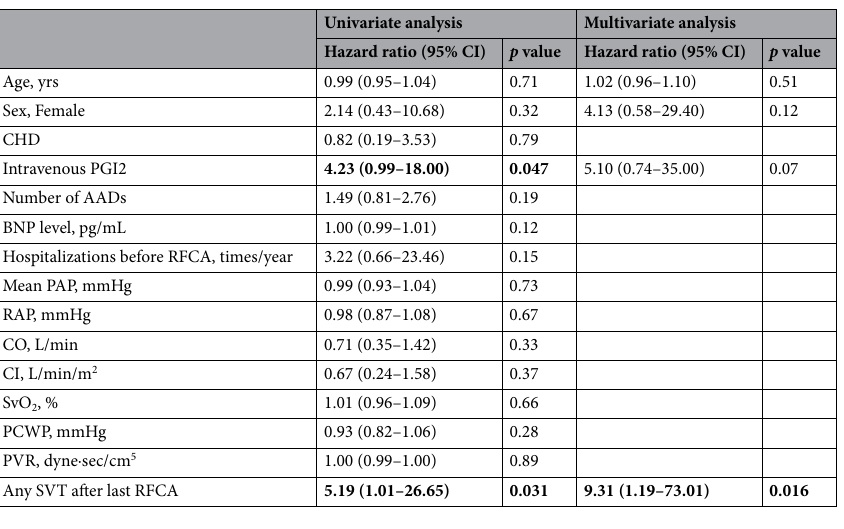
Table 2. Cox regression analysis of risk factors for mortality. AAD antiarrhythmic drug, BNP: brain natriuretic peptide, CHD: congenital heart disease, CI: cardiac index, CO: cardiac output, PAP: pulmonary artery pressure, PCWP: pulmonary capillary wedge pressure, PG: prostaglandin, PVR: pulmonary vascular resistance, RAP: right atrium pressure, RFCA: radiofrequency catheter ablation, SvO 2 : mixed venous oxygen saturation, SVT: supraventricular tachycardia.